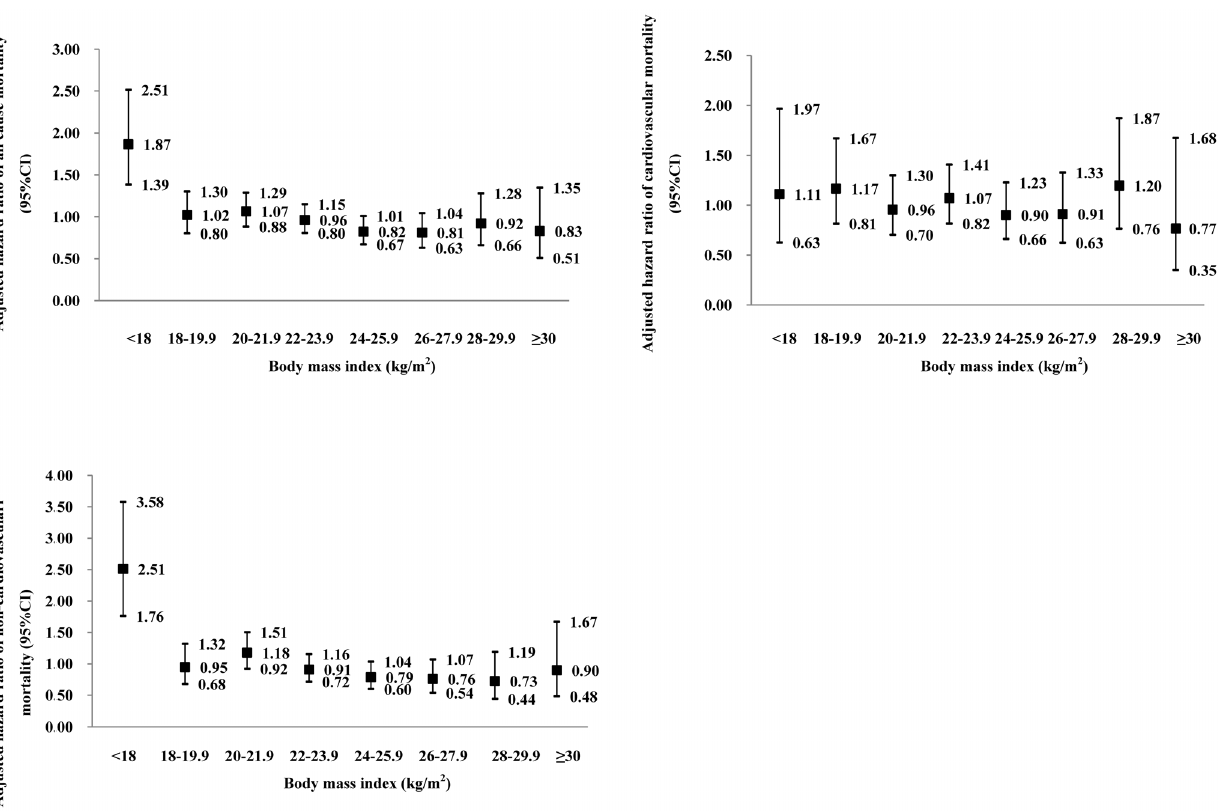
Figure 2. Multivariable-adjusted hazard ratios (95% CI) for all causes mortality, cardiovascular mortality and non-cardiovascular mortality across eight groups of body mass index (BMI). The hazard ratio express the risk in the BMI group compared with the average risk in the whole study population, which were adjusted for sex, age, smoking, drinking, physical activity, systolic blood pressure, history of cardiovascular disorders, serum lipid disturbance, diabetes mellitus and antihypertensive drug